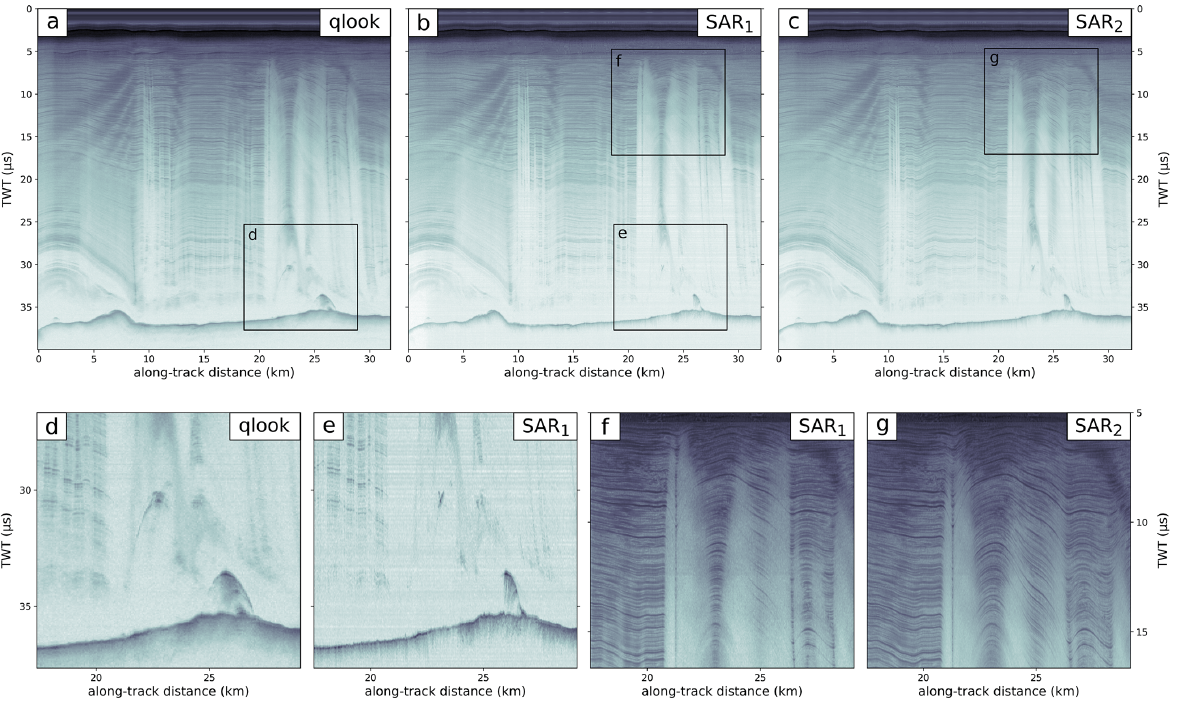
Figure 4. Radargrams of a flow-perpendicular radar profile showing the three different data products: (a) quick-look (qlook) processed, (b) SAR-focused (SAR 1 ), and (c) SAR-focused with a larger aperture (SAR 2 ). The main difference between qlook and SAR 1 is the focusing of signals via fk migration (d, e) . In contrast to the default SAR focusing (f) a larger aperture enables a better resolution of steeply inclined internal layers (g)